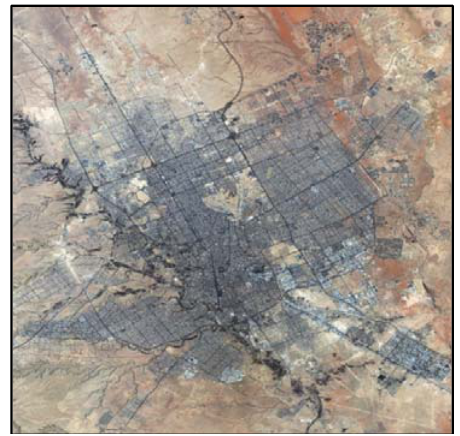
Figure 2b. Riyadh city (Satellite Sensor: Ikonos, GSD:1m,Acquisition Date:2008)